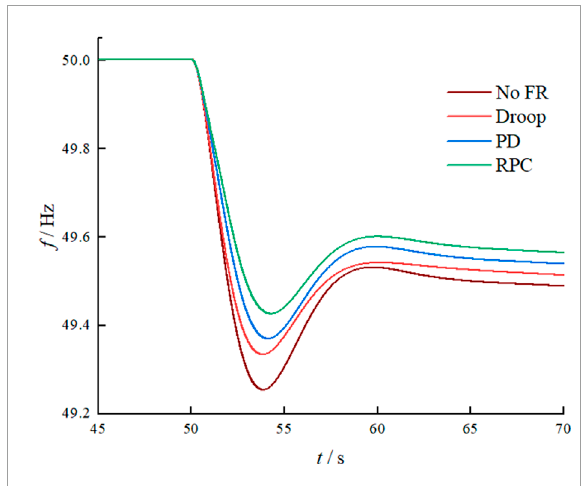
FIGURE 12 Sending end grid frequency in the event of sudden change in wind